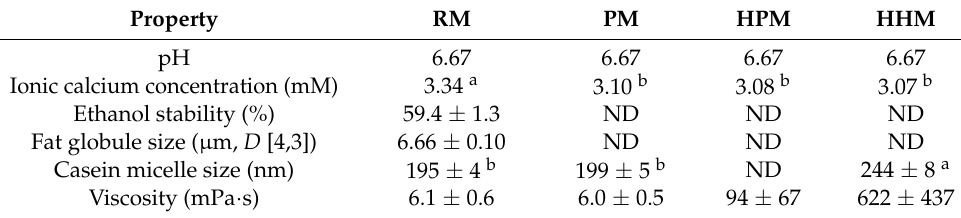
Table 4. Physicochemical properties of differently processed deer milks